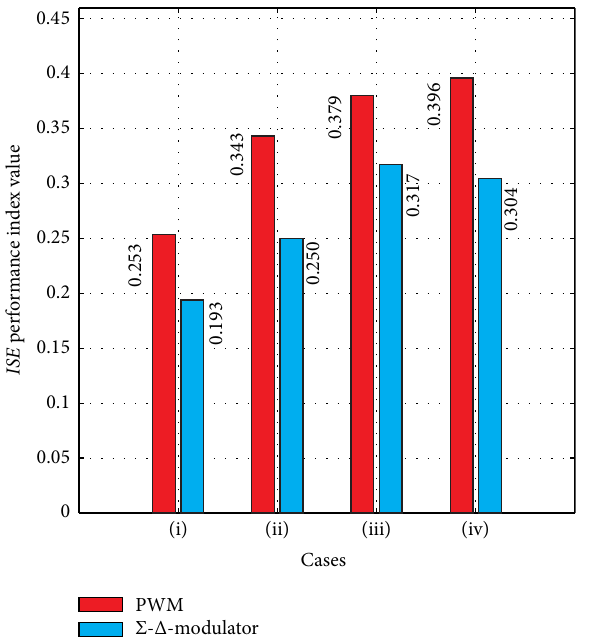
Figure 13: Values of the modulators’ ISE performance indices.